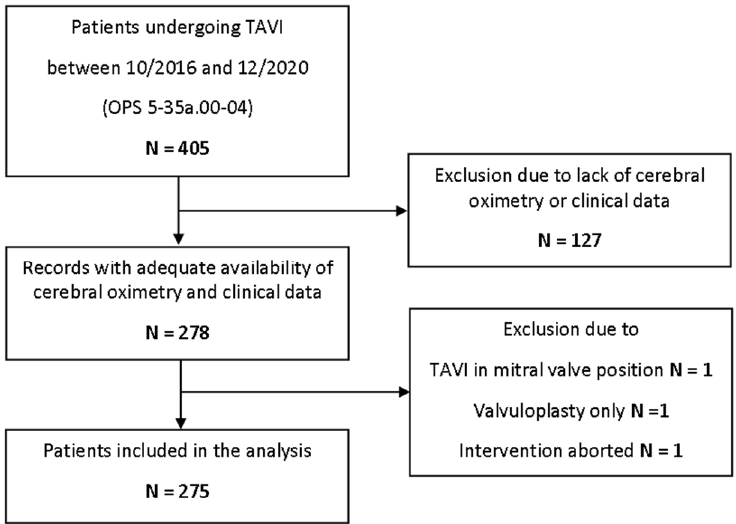
Figure 1. Study flowchart. TAVI = transcatheter aortic valve implantation.